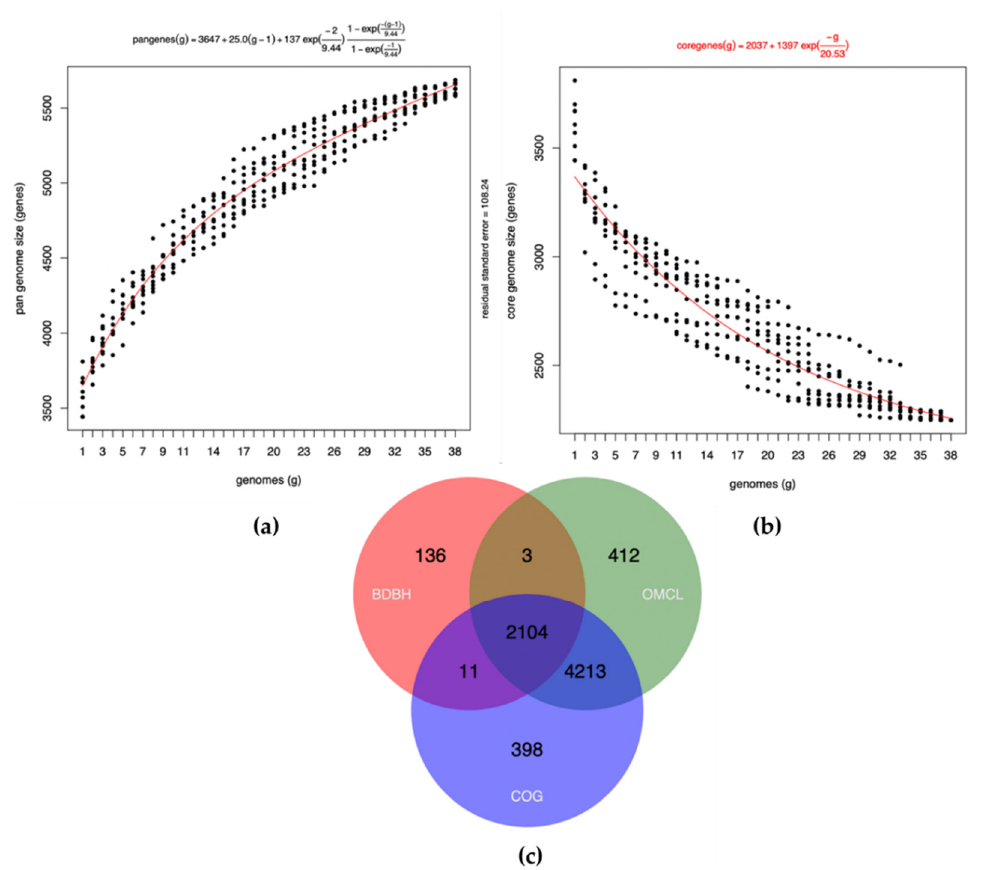
Figure 3. Plot of the estimation of pan- and core-genome sizes of Bacillus pumilus UAMX fitted with Tettelin function. ( a ) Pan-genome; ( b ) core-genome estimates; ( c ) Venn diagrams of core-genomes generated by BDBH, COG, and OMCL strategies.